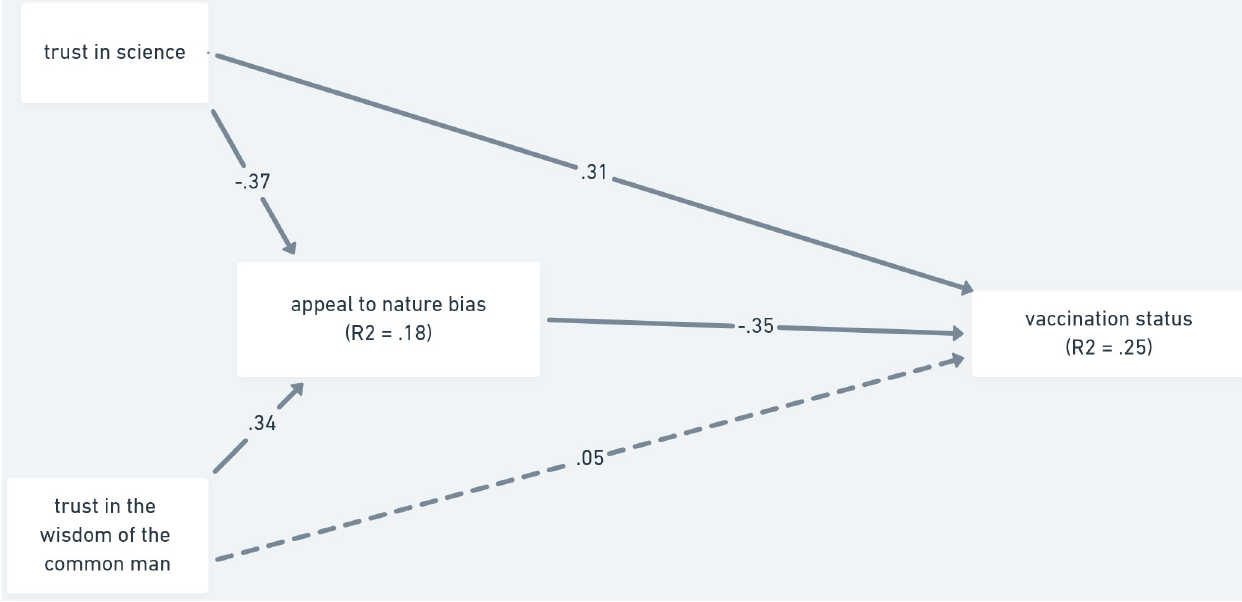
Fig 4. Mediation analysis of trust as a predictor of vaccination status via the appeal to nature bias—Study 2. Note . The paths are shown with standardized estimates. Non-significant paths are shown as dashed lines.